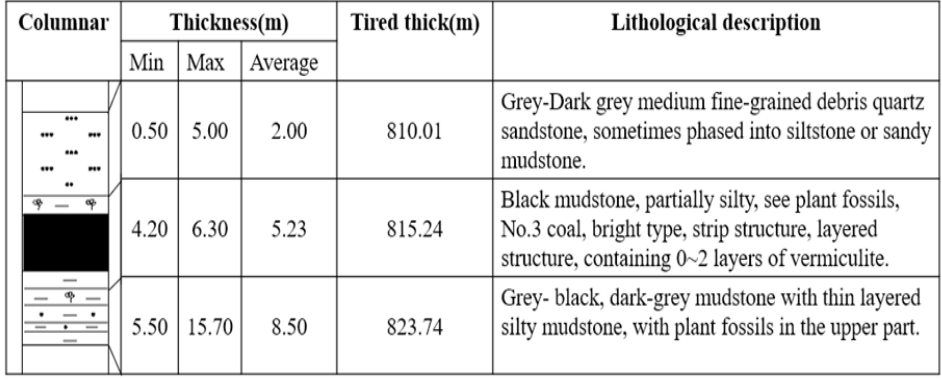
Figure 4. Comprehensive histogram of strata.